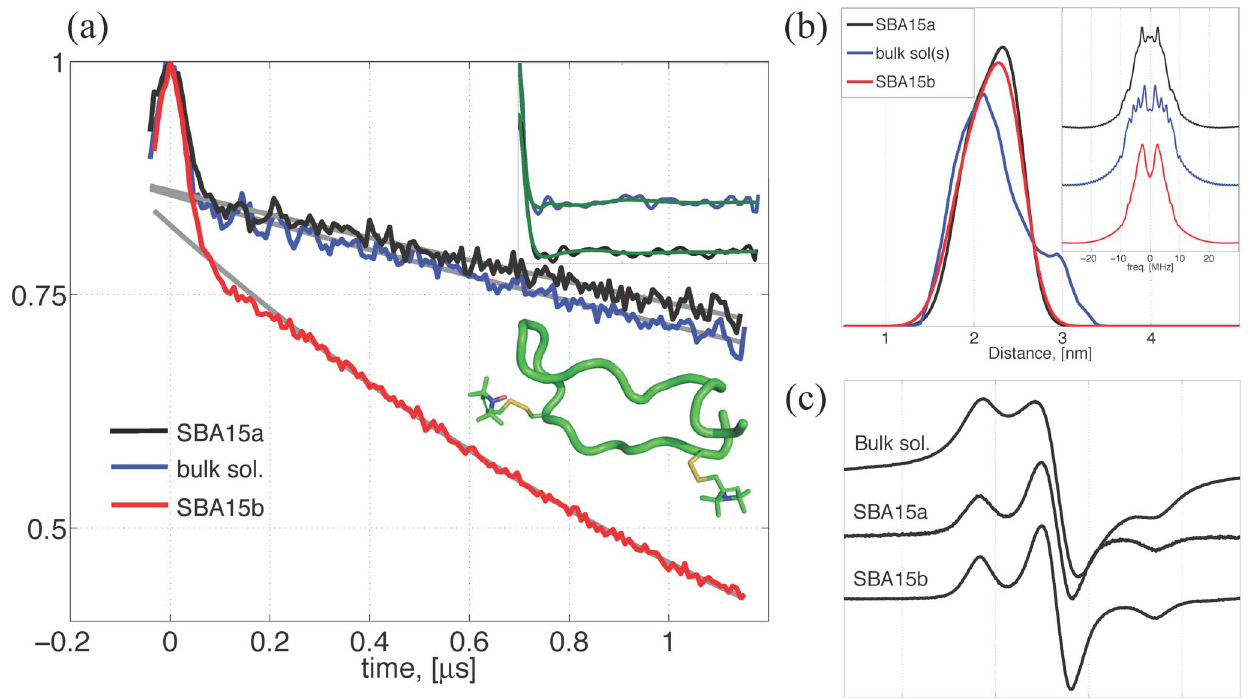
Figure 1. Determination of the n3 b -d structure. (a) The time-domain DEER data for the n3 b -d (0.5 mM) in the studied conditions, including the vitrified bulk solvent (sol(s)/H 2 O) and the nanochannels (SBA15a and SBA15b). The gray lines represent the exponential baselines that best fit the DEER data. There are two insets. One displays a ribbon model for the n3 b -d showing the spin-label side-chains at the 3rd and 9th sites of the peptide. The model was derived from a NMR study (PDB code: 1G04). The other inset shows the baseline-corrected DEER traces for the sol(s)/H 2 O and the SBA15a, and also the simulated DEER traces (in green color) using the obtained P(r)s. There are some distinct differences in the two traces. (b) The (normalized) interspin distance distributions of the n3 b -d peptides in the conditions studied. The average distances of the three measurements are approximately the same, indicating the n3 b structure remains roughly unchanged. A much-broadened P(r) for the bulk solution study is obtained due to the solvent heterogeneity. The inset shows the Pake doublets converted from the DEER data. (c) Cw-ESR spectra of the n3 b -d at 50 K. The clustering, caused by the solvent heterogeneity at 50 K, is evidently observed in the cw-ESR spectra of the bulk solution study, but not in the nanochannel